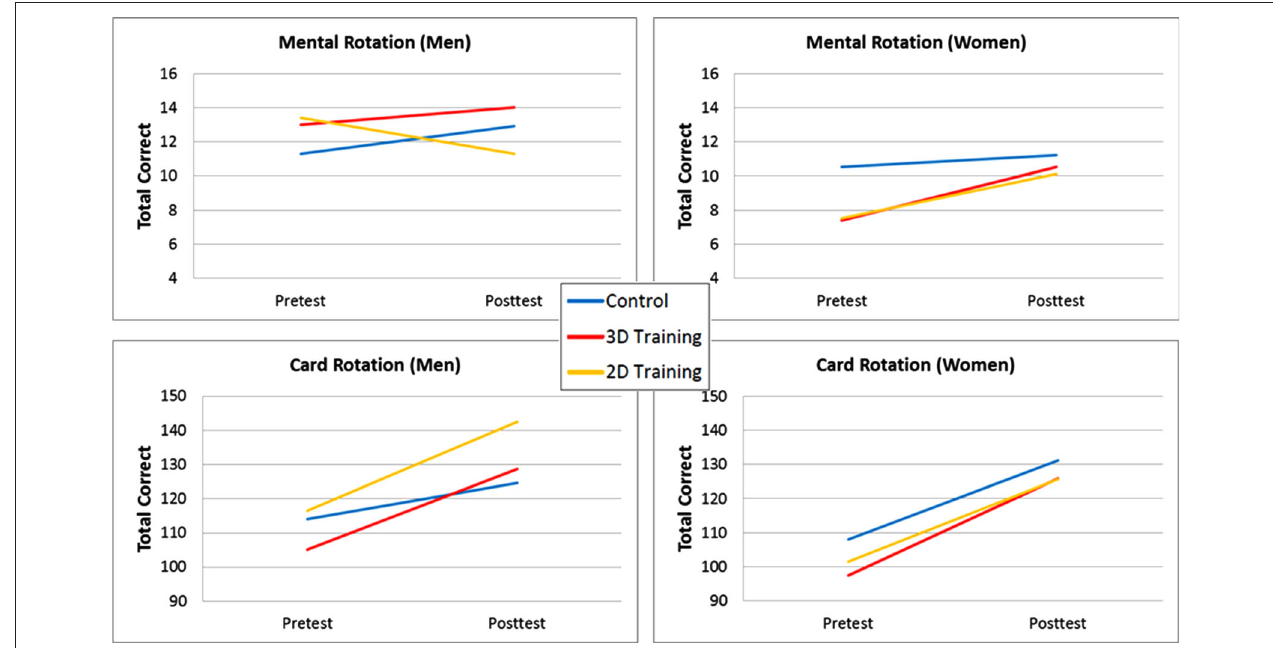
FIGURE 2 | Spatial ability transfer results as a function of gender and group for Cherney (2008)